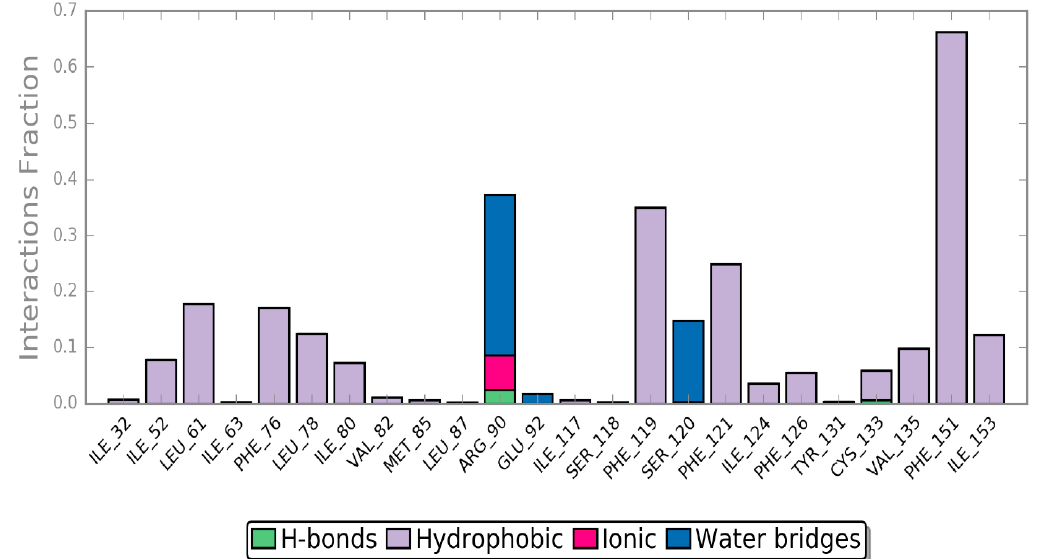
Figure 12. The stacked bar charts of MD-2 interaction with compound 5 .